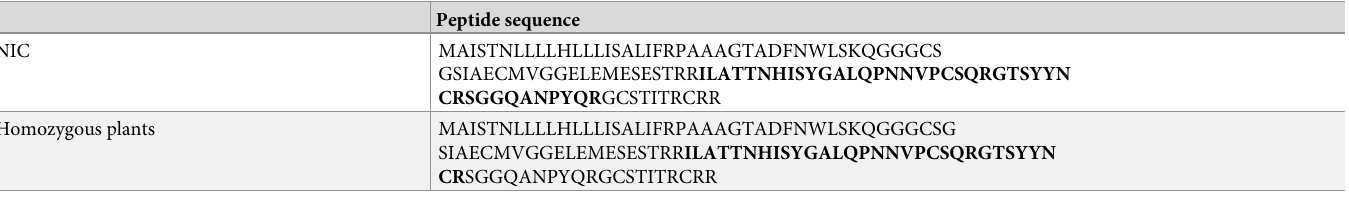
Table 1. Analysis of crude protein extracts from NIC and homozygous knockout plants of the BC1 generation by mass spectrometry using full-length TkRALFL1 peptide sequence as reference. Peptide sequence